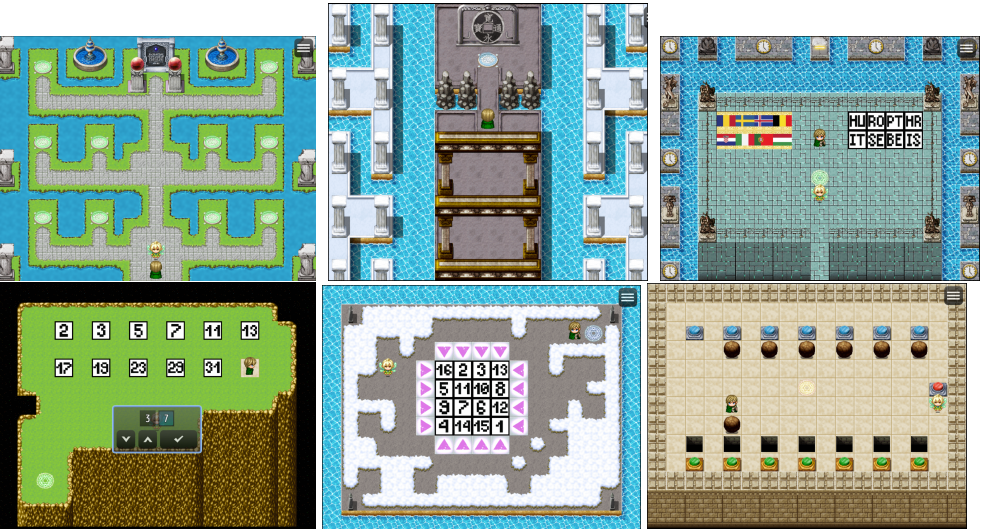
Figure 3. Screen captures of different quizzes designed with RPG